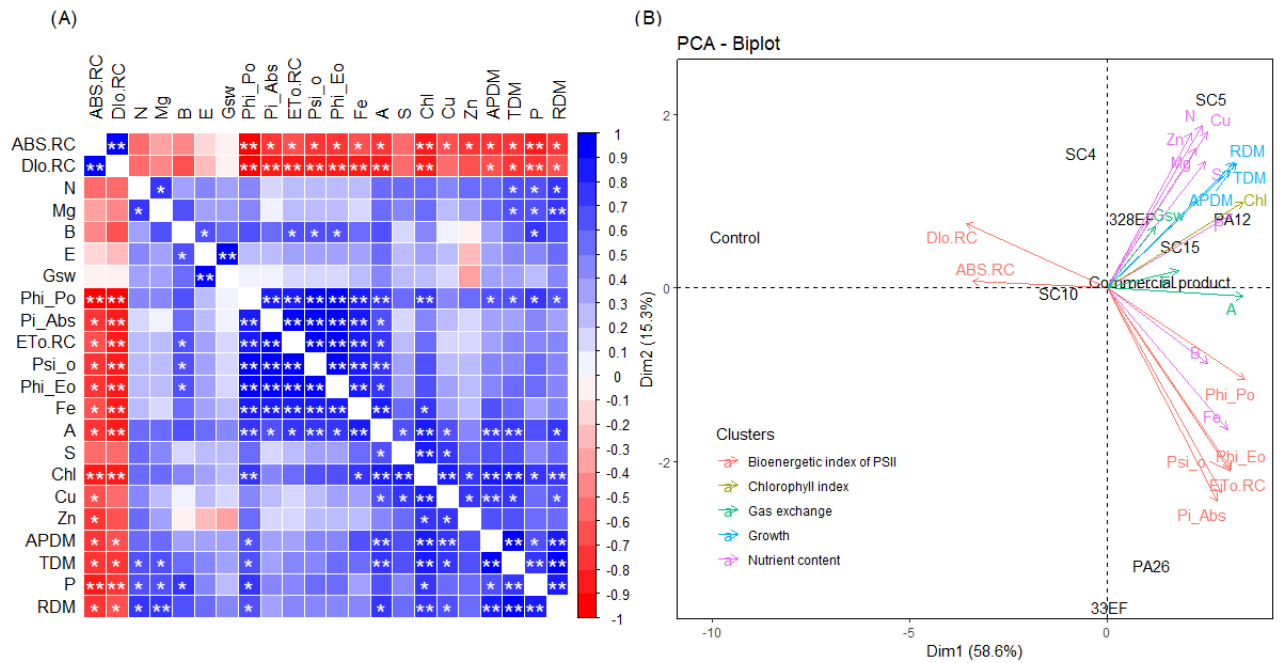
Figure 7. Correlations between the means of dry biomass, nutrient content, total chlorophyll, gas exchange, and chlorophyll fluorescence a parameters ( A ) and principal component analysis of these variables ( B ) in soybean plants ( Glycine max) inoculated with fungal and bacterial strains isolated from Hymenaea courbaril and Butia purpurascens and grown in a controlled greenhouse system. SC5 = Bacillus cereus , SC10 = Bacillus thuringiensis , PA12 = Paenibacillus alvei, PA26 = Lysinibacillus fusiformis, SC15 = Penicillium sheari , SC4 = Epicoccum keratinophilum, 33EF = Hamigera insecticola , 328EF = Codinaeopsis sp., Biomaphos ® = Bacillus megaterium and Bacillus subtilis , Control = without microorganisms. * significant at 0.5 and ** significant at 0.1 probability.